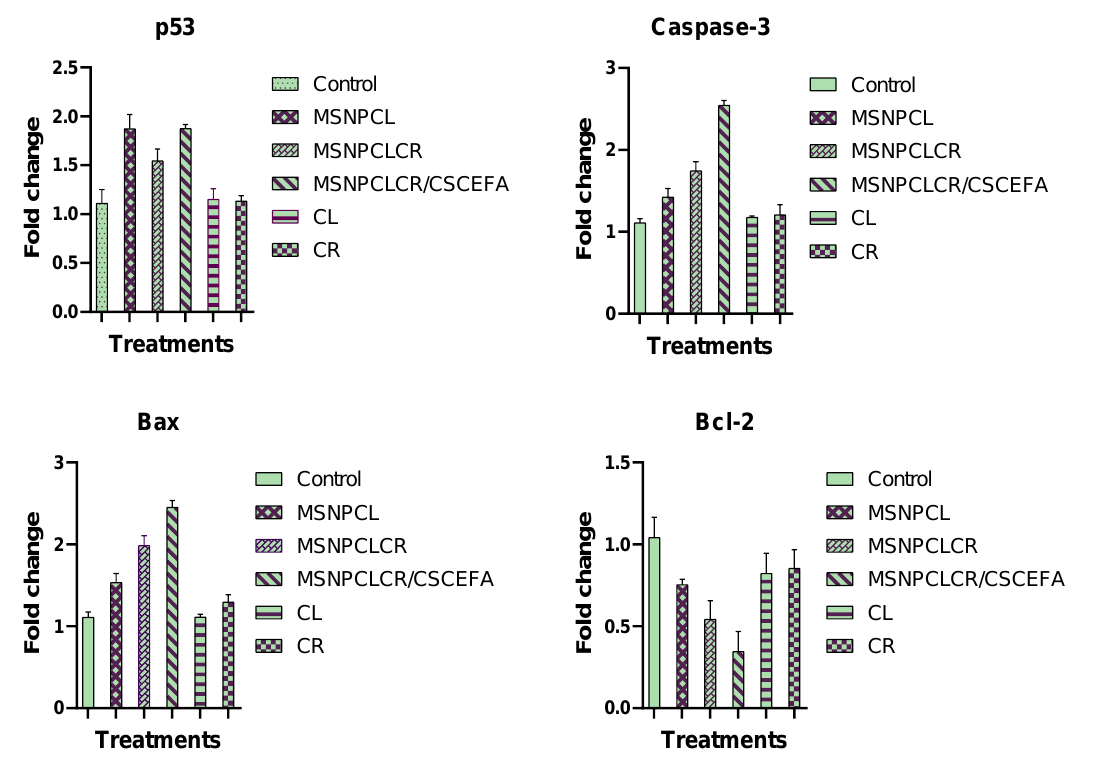
Figure 9. RT–PCR measurements of p53, caspase-3, Bax, and Bcl-2 markers of apoptosis for nanofor- mulations compared with free CL and CR against HOS cancer cells treated at the IC50 concentration (µg/mL) of each formulation by incubation for 72 h. Data are presented as mean ± SD. The concen- tration was prepared for nanoformulations as an equivalent concentration of CL and CR in the nanoformulation equal to free CL and CR.